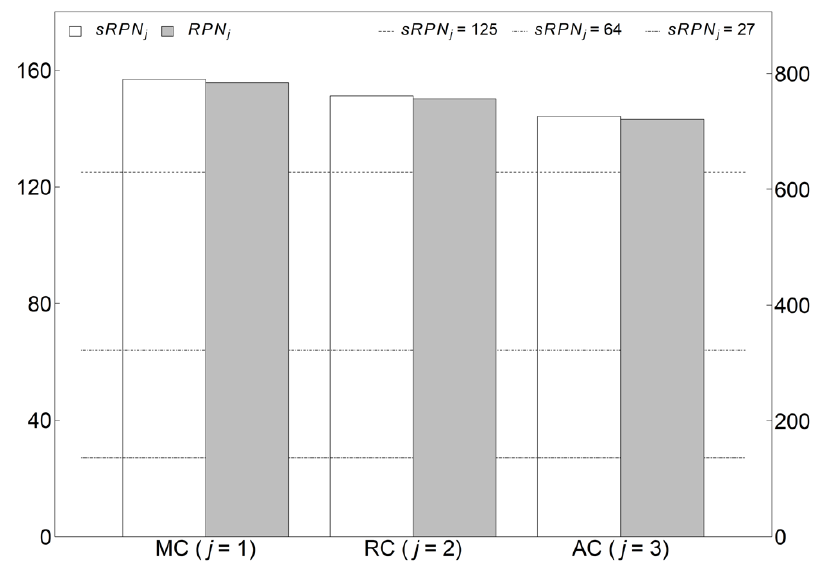
Figure 4. RPNs of the scenario in three operational modes.